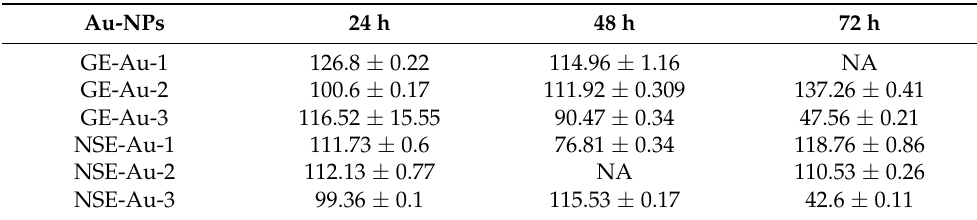
Figure 7. Cytotoxicity of various concentrations of GE- and NSE-conjugated Au-NPs against MDA-MB-231 cells. Results are shown as mean ± SD ( n = 3). Table 3. IC50 values ( µ g/mL) of various concentrations of GE- and NSE-conjugated Au-NPs against HCT 116 (colorectal cancer) cell lines at